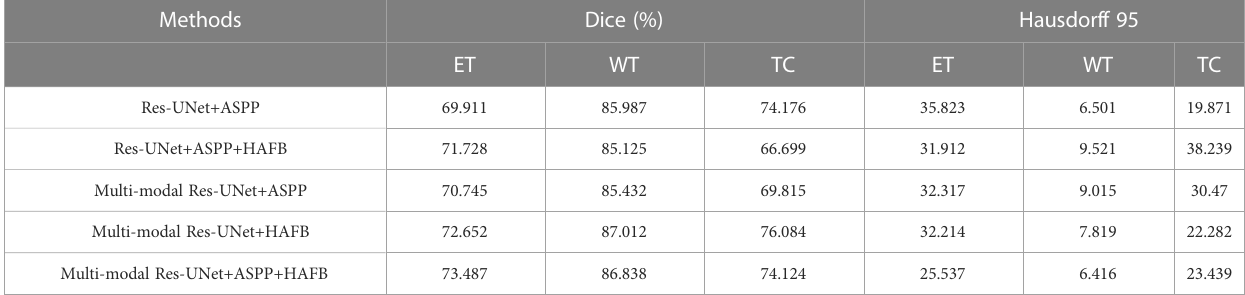
TABLE 4 Ablation experiment results on BraTS